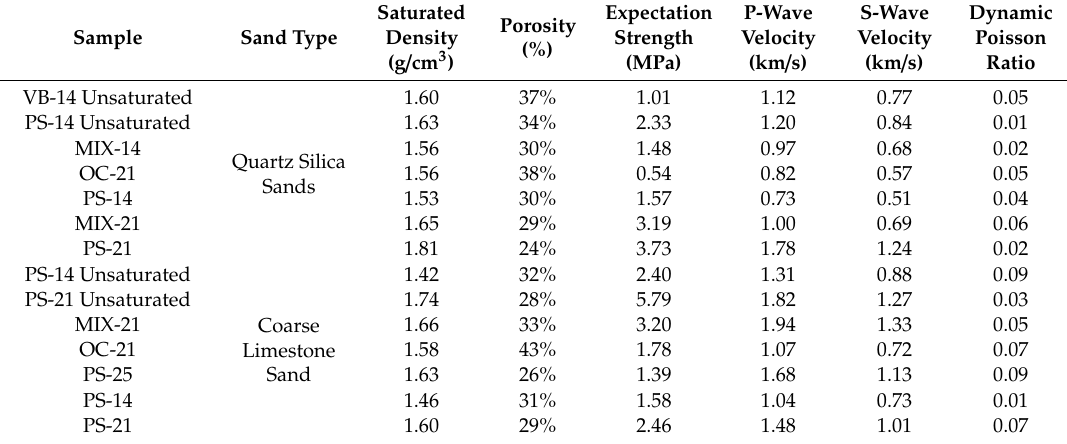
Table 3. Rock properties of artificial beachrock using the microbially induced carbonate precipitation (MICP)